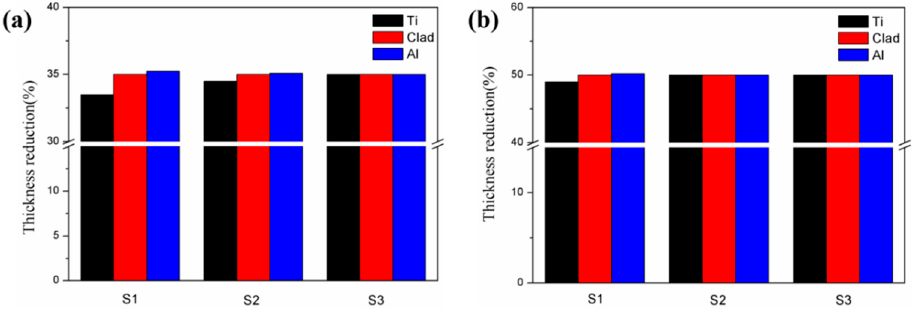
Figure 11. Effect of aluminum strength on the deformation of each layer of composite sheet under different reductions calculated using the model. ( a ) Reduction of 35%, ( b ) reduction of 50%.